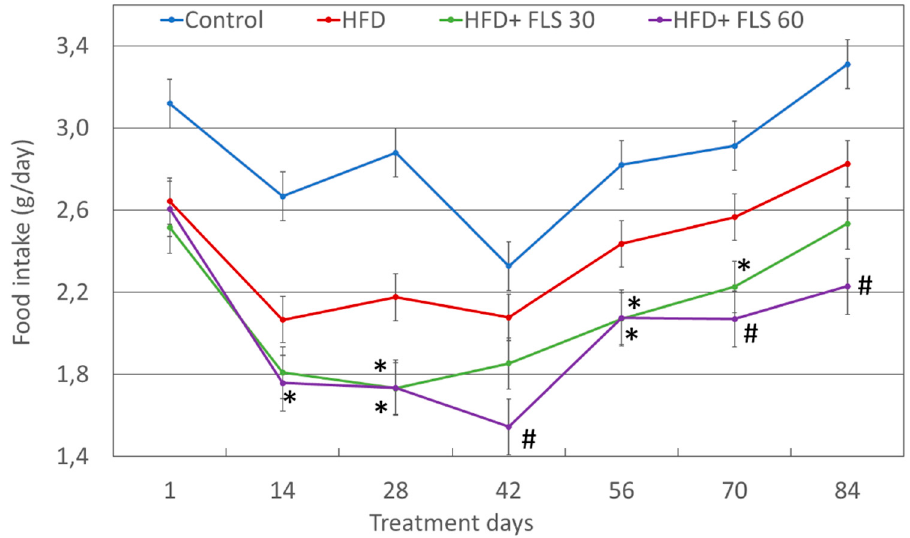
Figure 3. Average per capita food intake trend throughout the whole duration of the experiment. Error bars represent the standard error of the mean. Mice treated with FLS at both dosages showed a reduction in food intake, compared with the HFD group. *, p < 0.05; #, p < 0.01 compared to the HFD group.